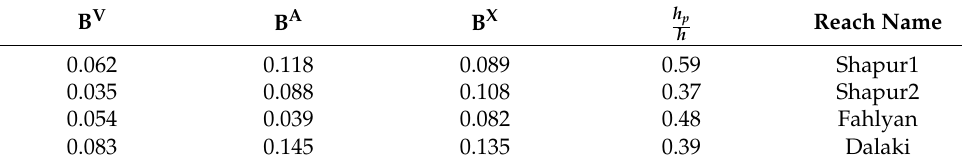
Table 2. Vegetation patches’ characteristics of the